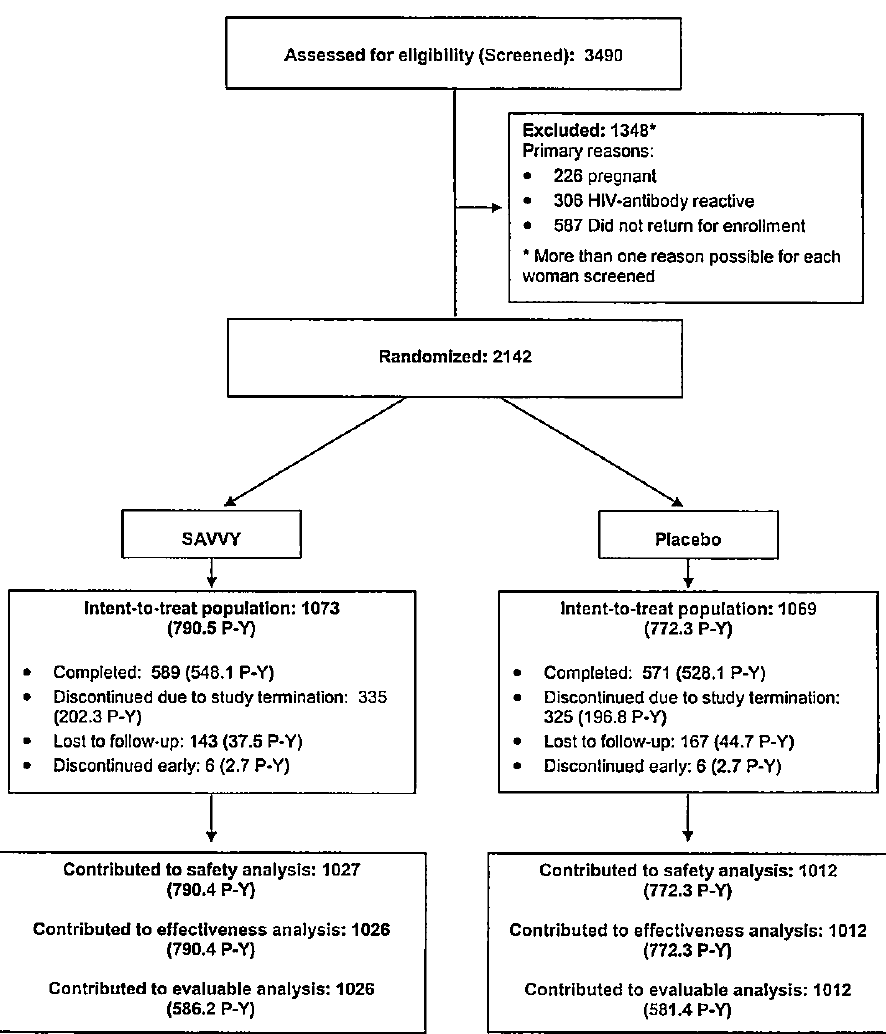
Figure 1. Participant Trial Flow Diagram (P-Y, person years).